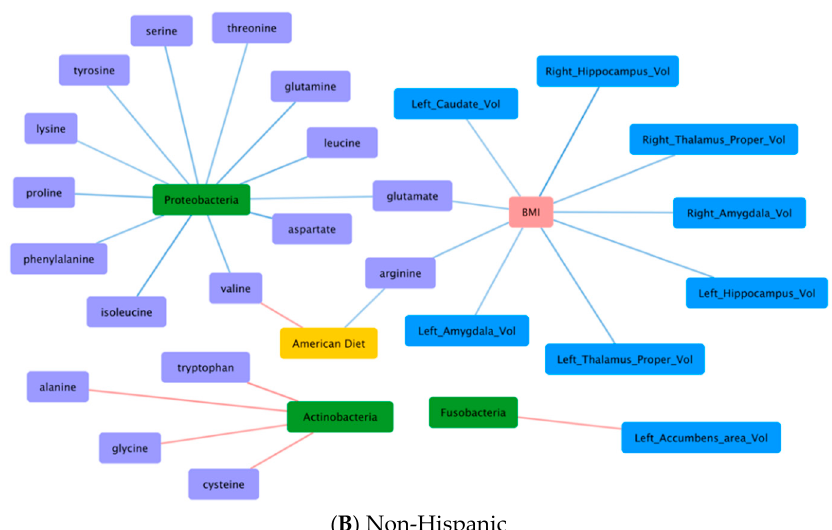
Figure 2. Pearson correlations of gut microbial, fecal amino acids, brain structural volumes, dietary pattern and BMI in Hispanics versus Non-Hispanics. Continuous mapping displayed positive (red) and negative (blue) correlation with darker color representing stronger correlation. Continuous variables include BMI (pink), diet (yellow), gut microbiome (green), fecal amino acids (purple), and brain structural volume (blue). Significant correlations ( q < 0.05) are used to build interaction networks for visualization.